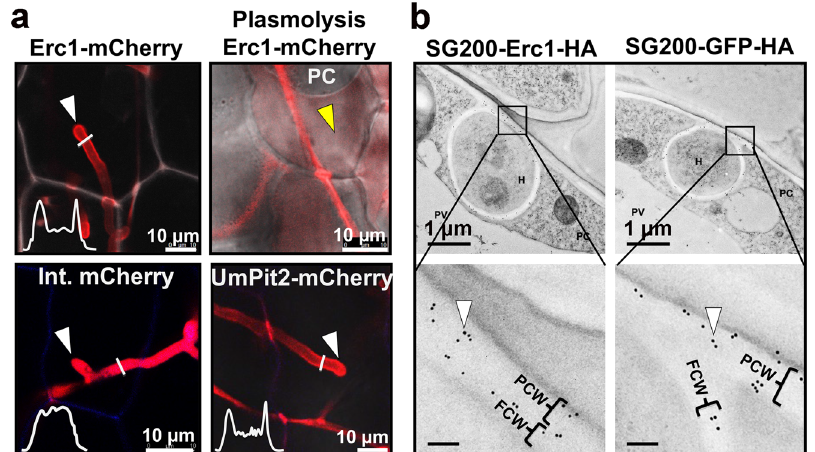
Fig. 3 | Localization of Erc1 in Ustilago maydis SG200 during maize coloniza- tion. a Erc1-mCherry was heterologously expressed in U. maydis SG200 strain under control of the native promotor with predicted native signal peptide for extracellular secretion. The SG200 strains expressing the Erc1-mCherry, UmPit2- mCherry (as a positive control for secretion) and cytosolic mCherry (int. mCherry; asanegativecontrolforsecretion)wereinoculatedonmaizeseedlingsandat4dpi confocal microscopy was performed to monitor the localization of each recombi- nant protein. While both Erc1-mCherry and UmPit2-mCherry are secreted around the tip of the invasive hyphae, internal mCherry localizes to the fungal cytoplasm. The white graphs indicate the mCherry signal intensity along the diameter of the